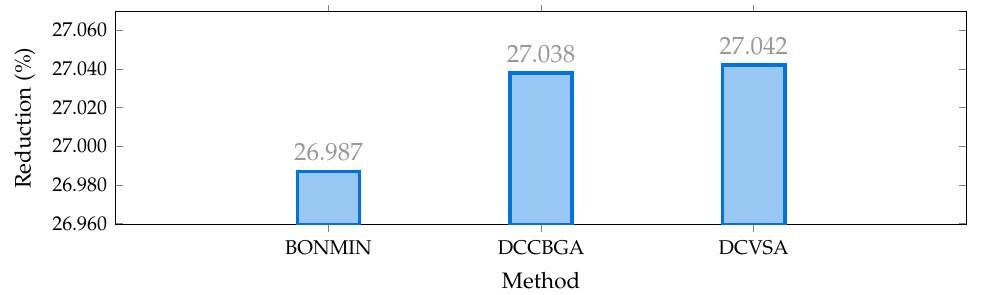
Figure 4. Percentage of reduction of the total grid operative costs in the IEEE 33-bus system in its AC version.